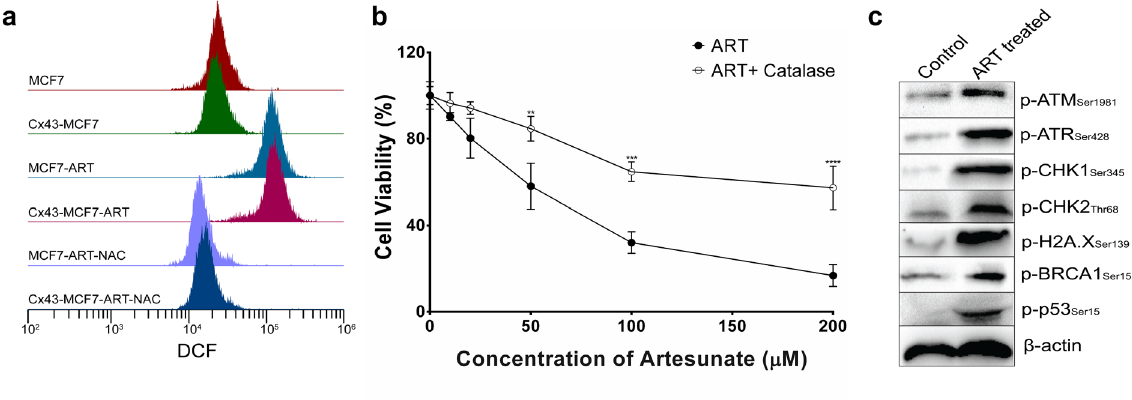
Figure 4. ROS generation and DNA damage analysis. ( a ) Generation of ROS in MCF7 and Cx43-MCF7 cells were assessed by measuring DCF fluorescence using flow cytometer. Untreated MCF7 and Cx43-MCF7 cells were taken as control and cells were treated in presence or absence of antioxidant NAC (5 mM). ( b ) Cell viability assay of MCF7 cells after treatment with ART in presence or absence of catalase. ( c ) ART induced DNA damage response in MCF7 cells upon exposure. Phosphorylation of ATM, ATR, Chk1, Chk2, histone H2A.X, BRCA1, and p53 was determined 8 h after the onset of treatment. β -actin was used as an endogenous control and to ensure equal proteins levels. The band intensity of the respective proteins were quantitated by densitometric analysis (supplementary Fig.